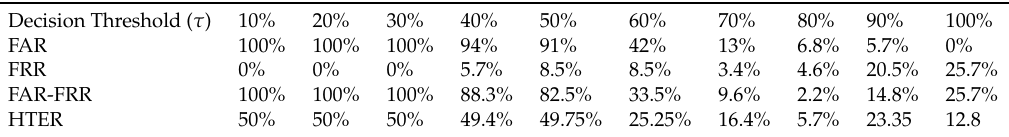
Figure 5. Detection of Error Trade-off (DET) plot showing an Equal Error Rate (EER) of 2.2%. FFR, False Fake Rate; FLR, False Living Rate. Table 2. Optimization for the decision threshold ( τ ) for auditory perception. HTER, Half Total Error